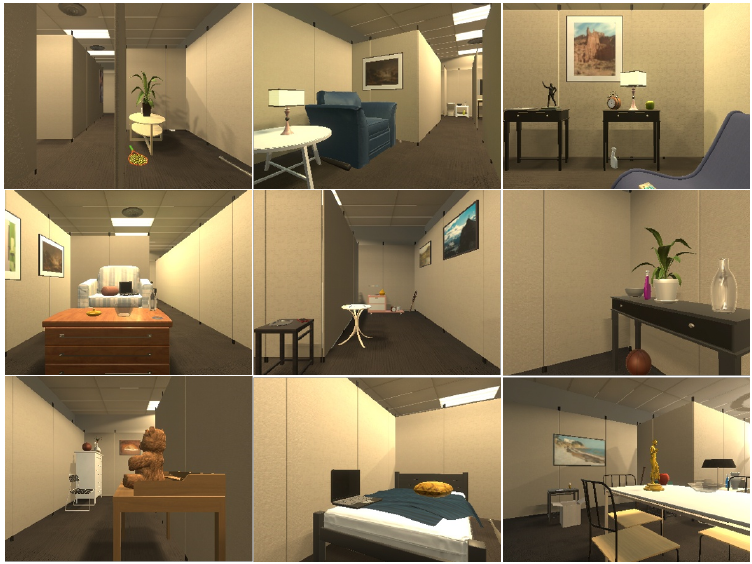
Figure 6. Agent egocentric RGB images for RDMAE visual pretraining.